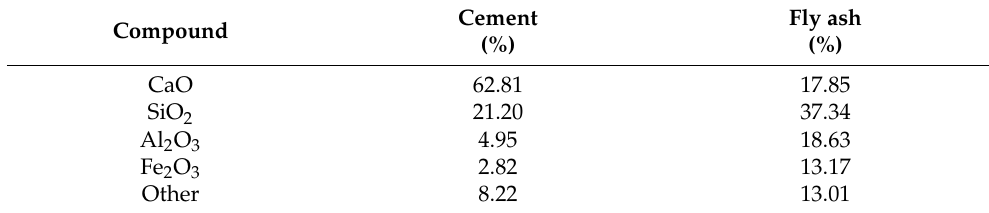
Figure 4. ( a ) Cement, ( b ) fly ash, ( c ) SEM photos of cement and ( d ) fly ash particles; ( e ) small gravel, and ( f ) large gravel used in this study. Table 1. Chemical compositions of type 1 ordinary Portland cement and class-C fly ash used.